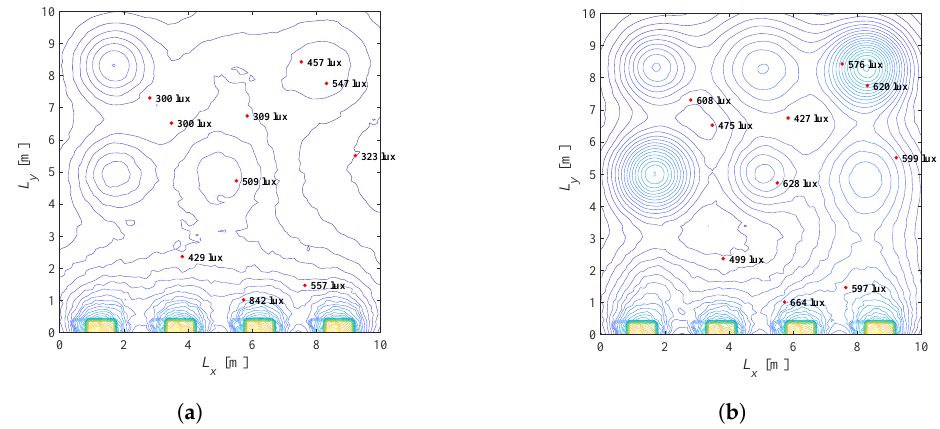
Figure 19. Solution of the Problem 5 defined in (23). ( a ) λ = 0.01, a = 0.39, G = 0.19. ( b ) λ = 0.5, a = 0.29, G =